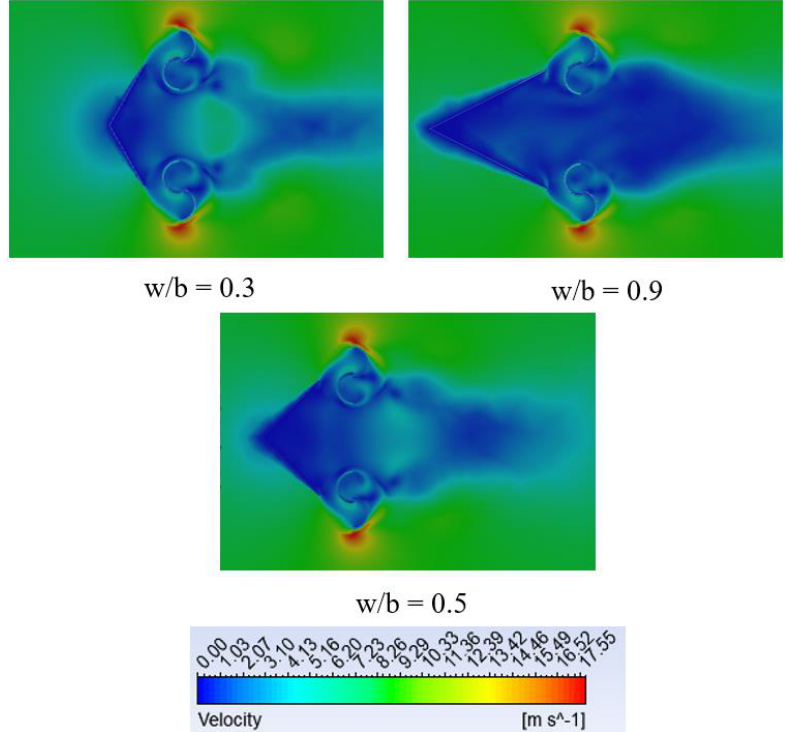
Figure 10. The effect of triangular plate end width with velocity contours.